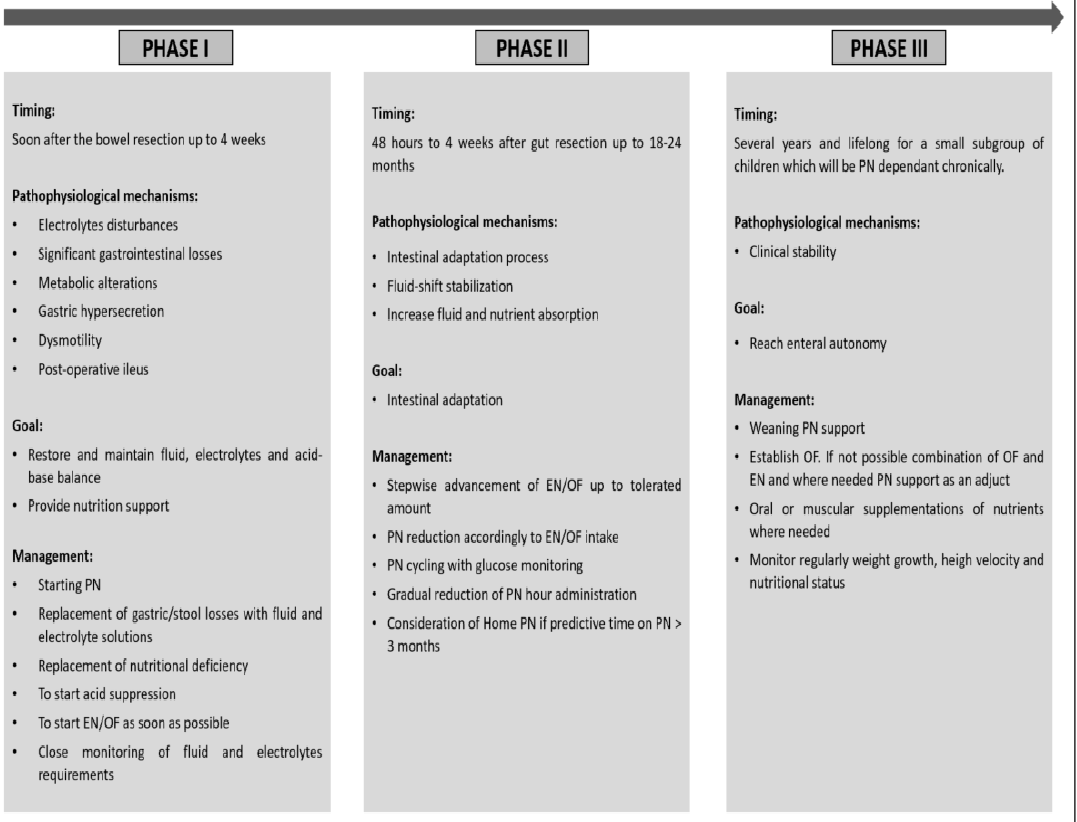
Figure 1. Nutritional management accordingly to pathophysiological phases of SBS.